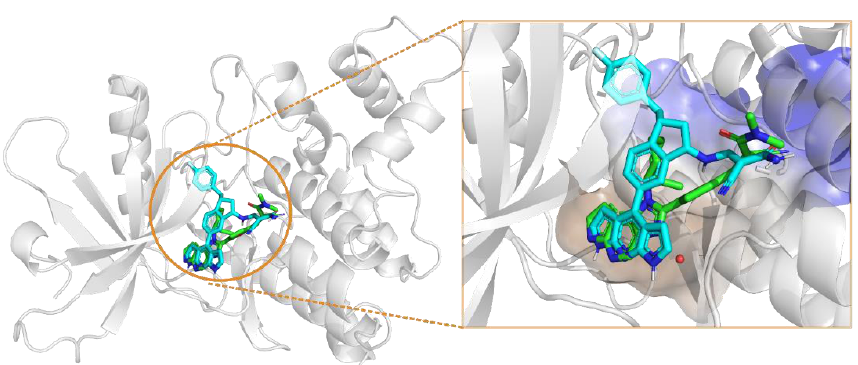
Figure 2. Stacking pattern of inhibitor 8 with eutectic ligand (inhibitor 4) in the JAK3 activity pocket, with inhibitor 8 in blue, inhibitor 4 in green, and water molecules in the solvent-exposed region in